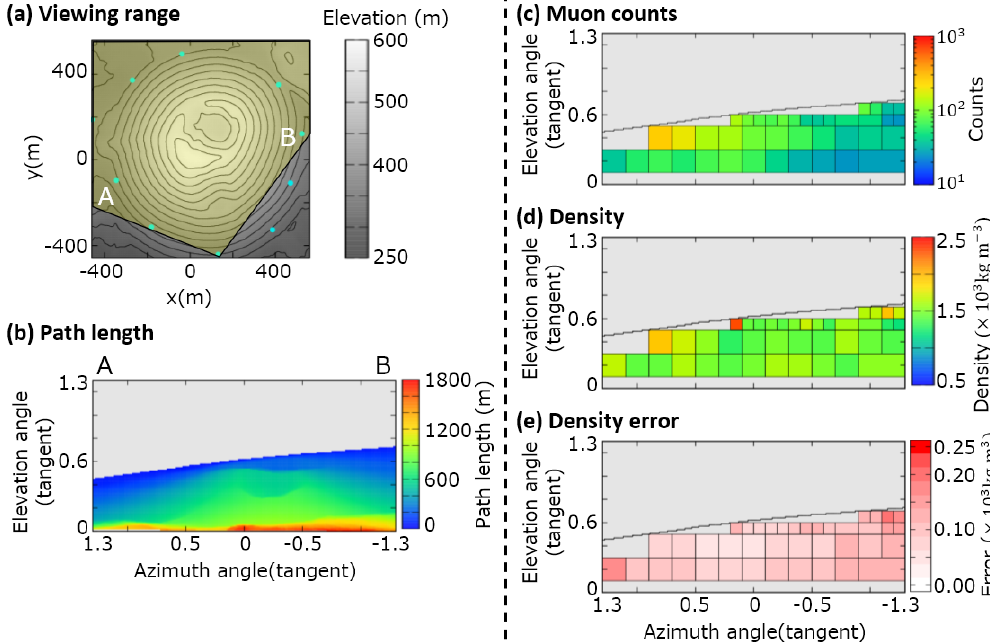
Figure 12. Data for observation site N. (a) Map, topography, and viewing range; (b) path length of the volcanic cone; (c) muon counts N obs ; (d) density ρ i . The maximum value of the color bar indicates a density of > 2 . 5 × 10 3 kgm − 3 and the minimum value is < 0 . 5 × i (cid:16) (cid:17) − ρ low ρ up / 2. The maximum value of the color bar indicates a density error of > 0 . 25 × 10 3 kgm − 3 . 10 3 kgm − 3 . (e) Density error (cid:49)ρ = i i